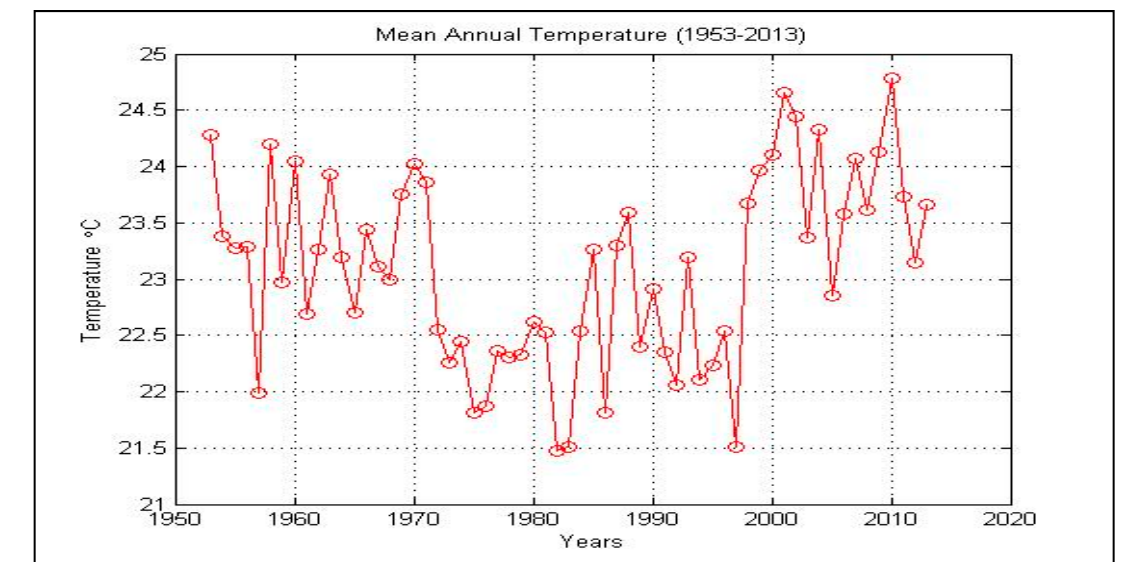
Figure 14. Mean annual temperature of Abbottabad 1953–2013.